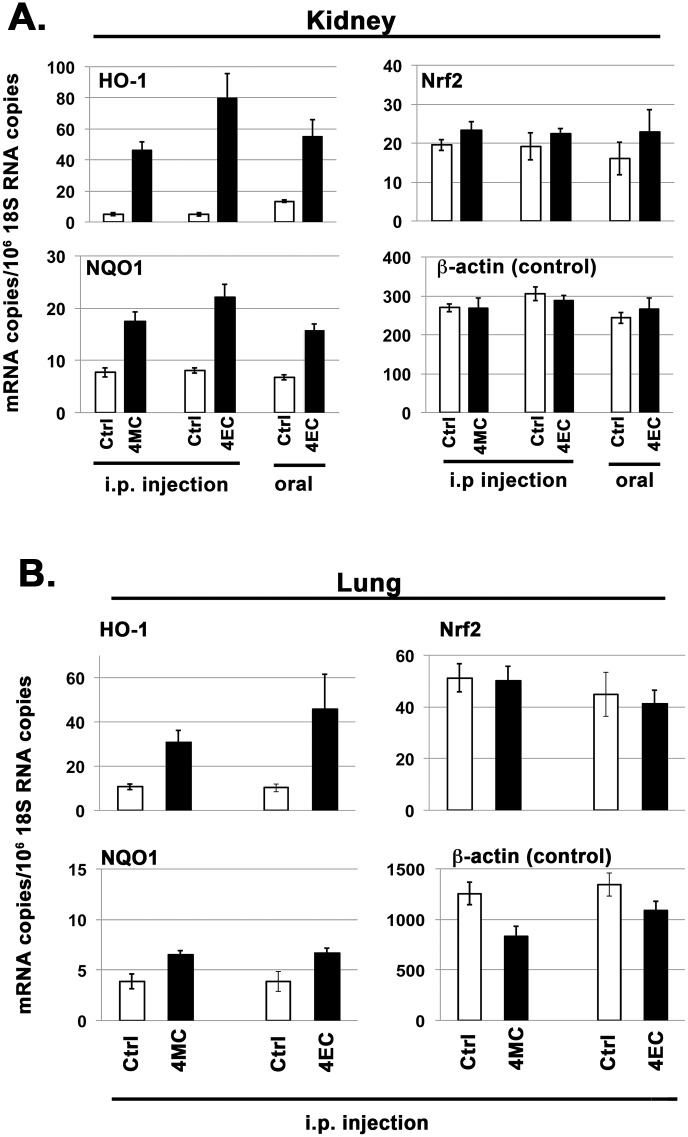
Induction of Nrf2 target genes in mice by 4-methylcatechol and 4-ethylcatechol.RT-PCR analyses; Y-axis = (mRNA copies)/(106 18S rRNA copies). Error bars = ± S.D.; n ≥ 4 for each data point. (Panel A, Kidney) Mice received either intraperitoneal (i.p.) injection or oral gavage of vehicle control (Ctrl), 4-methylcatechol (4MC), or 4-ethylcatechol (4EC) at time zero and again at time zero + 2 hours, for at total dose of 50 mg/kg. Mice were harvested at time zero + 4.5 hours and kidneys dissected for RNA isolation. (Panel B, Lung) 4MC or 4EC, as indicated, were administered i.p. at time zero and again time zero + 2 hours for a total of 50 mg/kg. Mice were harvested at time zero + 4.5 hours, and lungs dissected for RNA isolation. Summary of data analyses and statistical significance: Again, it is important to emphasize that the Nrf2 pathway is activated primarily by stabilization of Nrf2 protein that allows for transcriptional induction of Nrf2 target genes, such as HO-1 and NQO1; and therefore, that robust induction of HO-1 and NQO1 mRNAs, rather than Nrf2 mRNA, indicate Nrf2 pathway activation (see text). (Panel A) Inductions of HO-1 and NQO1 mRNAs by 4MC and 4EC, administered either i.p. or orally, were all statistically extremely significant (p < 0.001). For Nrf2: Ctrl vs. 4MC (i.p.) = significant (p<0.05); Ctrl vs. 4EC (i.p.) and Ctrl vs. 4EC (oral) = no significant differences. For β-actin: no statistically significant differences within experimental groups. (Panel B) For HO-1, Ctrl vs. 4MC = significant (p = 0.0176), Ctrl vs. 4EC = very significant (p = 0.0025). For NQO1, Ctrl vs. 4MC = significant (p<0.045) and Ctrl vs. 4EC = very significant (p = 0.0031). For Nrf2: Ctrl vs. 4MC and Ctrl vs. 4EC = no significant differences. For β-actin: Ctrl vs. 4MC = very significant (p<0.01) and Ctrl vs. 4EC = significant (p<0.04). Thus, β-actin mRNA was reduced by 4MC and 4EC in lung, in contrast to HO-1 and NQO1 mRNAs that were increased. However, 4MC and 4EC did not reduce β-actin in kidney (Panel A).